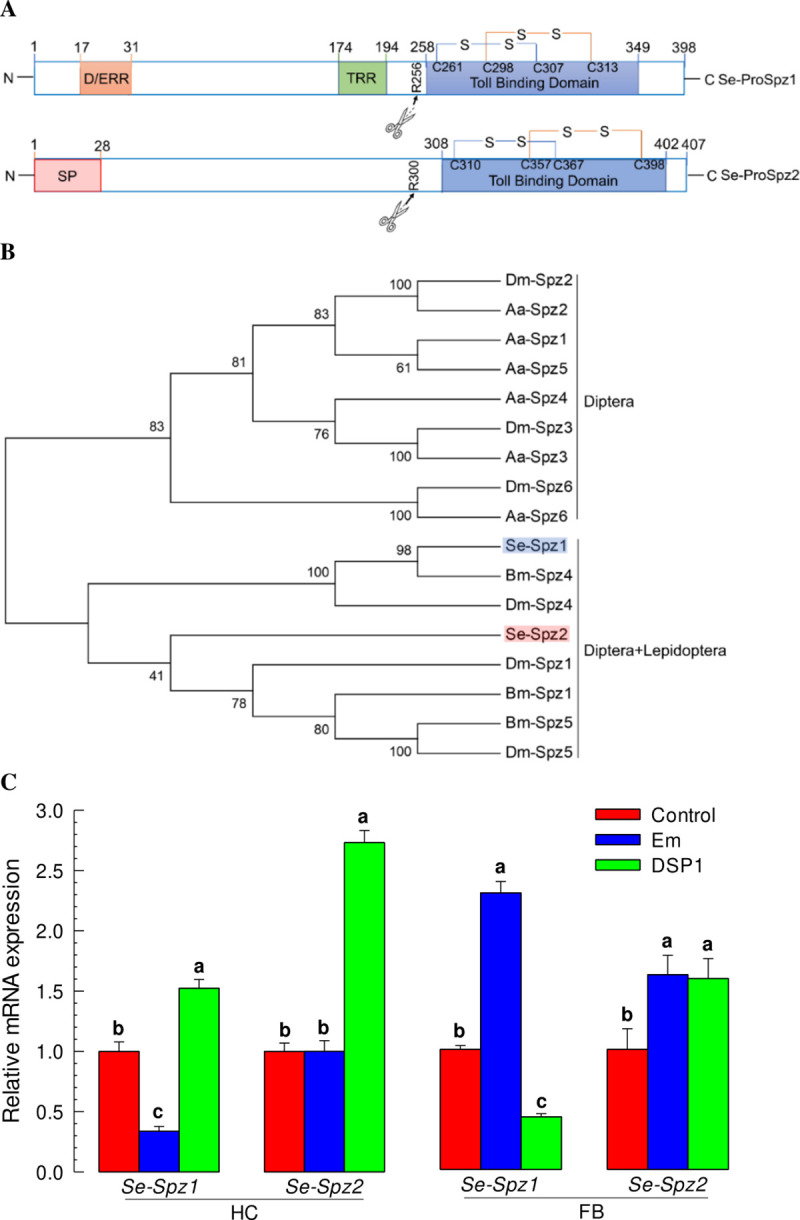
Two Spätzles (Se-Spz) of S. exigua.(A) Functional domains of two proSpätzles (‘Se-ProSpz1’ and ‘Se-Spz2’), including a SP (signal peptide), a D/ERR (aspartic/glutamic acid rich region), a TRR (threonine rich region), and a Toll binding domain. Scissors indicate cleavage sites during post-translational modification from Se-ProSpz1/2 to active Se-Spz1/2. Disulfide bonds are indicated by linking cysteine residues. (B) Phylogeny analysis of Se-ProSpz1/2 and those of other insects. The analysis was performed using MEGA6 program with a Neighbor-joining method. Bootstrapping values were obtained with 1,000 repetitions to support branching and clustering. Amino acid sequences were retrieved from GenBank with accession numbers shown in S2 Table. (C) Expression profile of Se-Spz1/2 in hemocyte (‘HC’) and fat body (‘FB’) of L5 larvae of S. exigua. rSe-DSP1 (‘DSP1’) was injected into L5 larvae at a dose of 0.8 μg/larva. Immune challenge was performed by injecting E. mundtii (‘Em’) to L5 larvae at a dose of 4 × 105 cells/larva. At 8 h PI, hemolymph and fat body were collected for RT-qPCR analysis. Control insects were injected with PBS. Expression levels of Se-Spz1/2 were presented as fold changes in comparison with those in control larvae. Expression level of a ribosomal gene, RL32, was used as reference to normalize expression levels of target genes. Each treatment was replicated three times. Different letters above standard deviation bars denote significant difference among means at Type I error = 0.05 (LSD test).